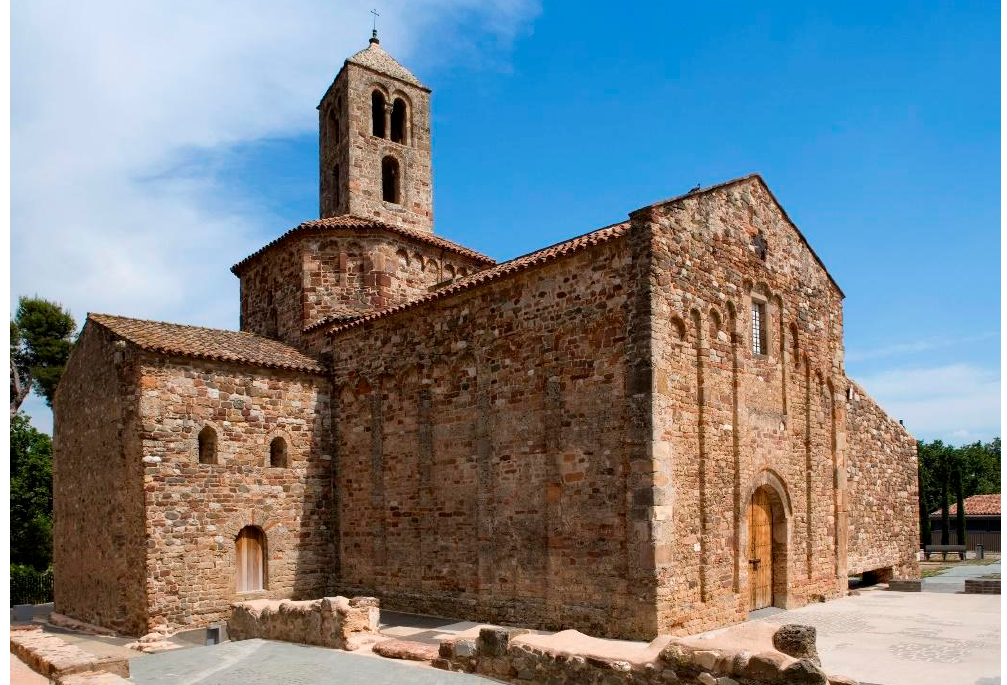
Figure 6. Church of Santa Maria de Terrassa. © Photo: Carles Sánchez.